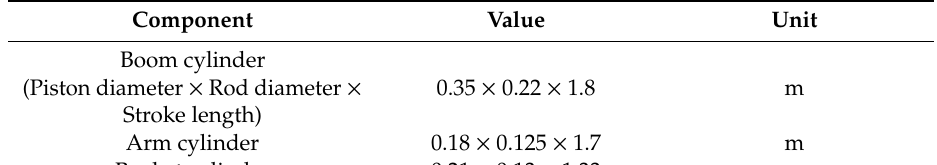
Table 6. Fuel cell system parameters [38,41].